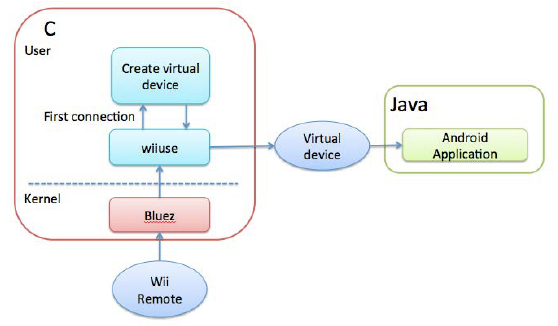
Fig. 5. use ioctl function